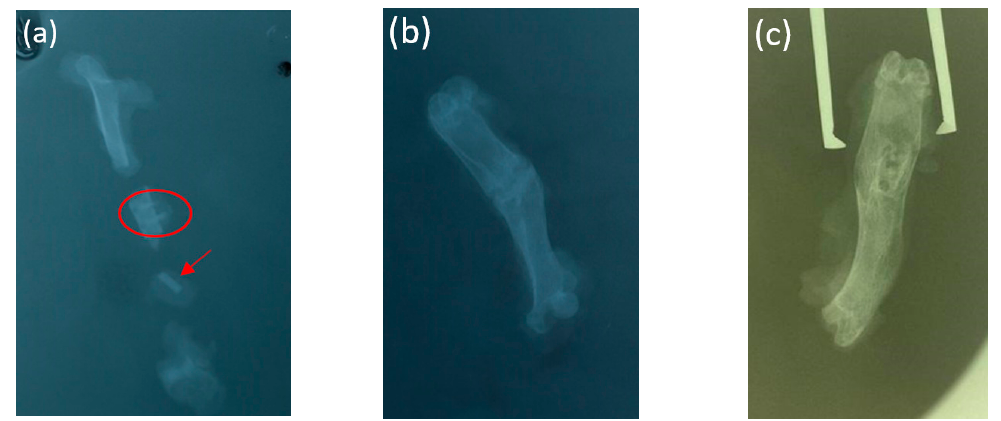
Figure 7. A snapshot of the fragments of the femur of an animal ( a ) 1 month, ( b ) 3 months, and ( c ) 6 months after implantation.